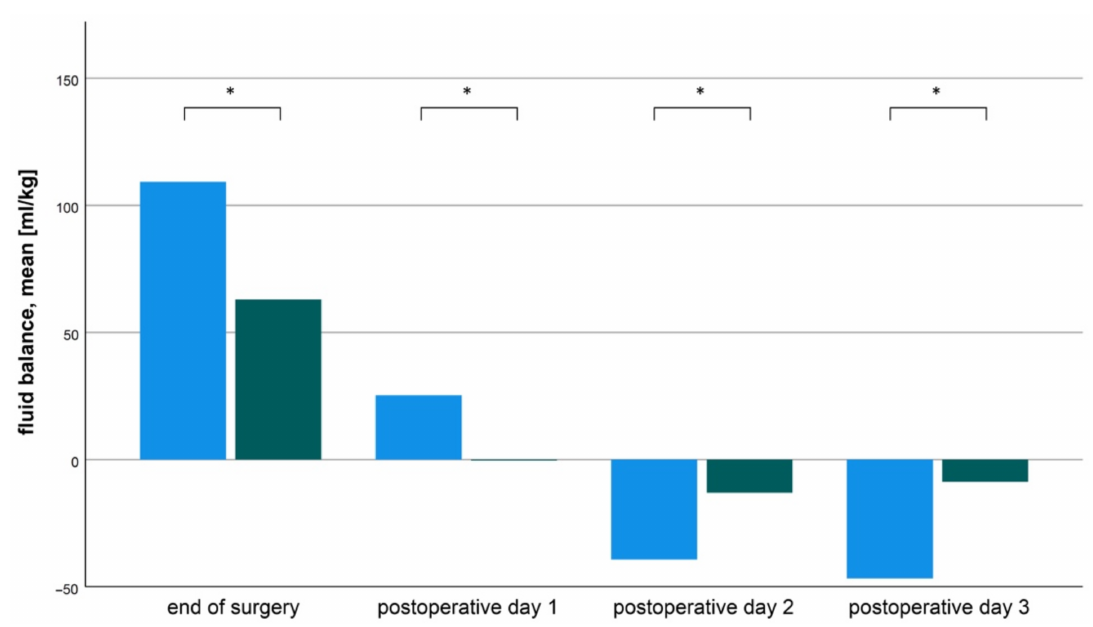
Figure 2. Perioperative fluid balance analysis revealed that the patients in the delayed extubation DET) group had significantly higher fluid shifts than the patients in the on-table extubation (OTE) group. In the diagram the mean fluid balance is shown. The columns represent the mean fluid balance at the time of end of surgery, 1st 2nd and 3rd postoperative day. Blue columns represent the DET group, green columns represent the OTE group. All differ significantly * p < 0.0001.